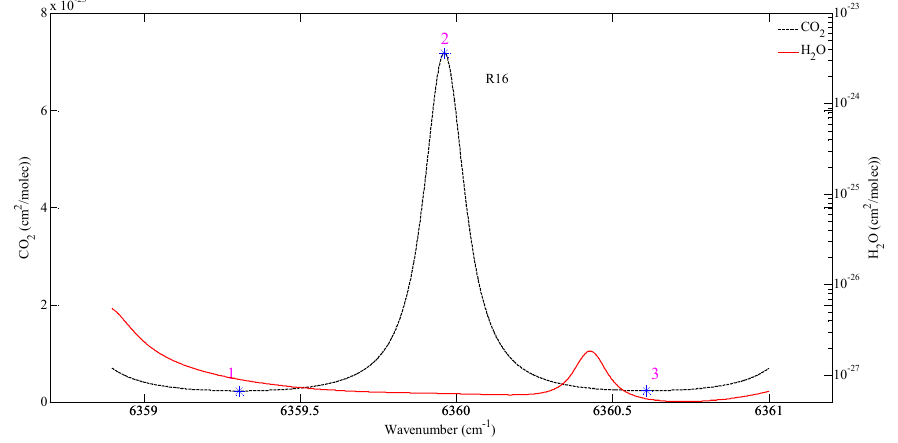
Figure 3. Selections of the on-line and off-line wavelengths in the region of R16 for the dual-wavelength DIAL (DW-DIAL). The black dotted and red lines are the absorption lines of CO 2 and H 2 O, respectively. According to Section 2, the DAOD of the on-line and off-line wavelengths could be easily obtained through the DW-DIAL: supposing that r 1 = 0, r 2 = 50, P ( λ on , r 1 ) = P ( λ off , r 1 ) = 4 mJ, C 0 = 400 ppm. In addition, σ g ( λ on ) and σ g ( λ off ) could be obtained from HITRAN 2012, which were 7.1785 × 10 − 23 and 2.2250 × 10 − 24 cm 2 , respectively. Then, N 0 = 1.0747 × 10 22 , and DAOD = ln 7.476 × 10 − 3 for the on-line and off-line wavelengths of DW-DIAL based on Equations (2) and (3).